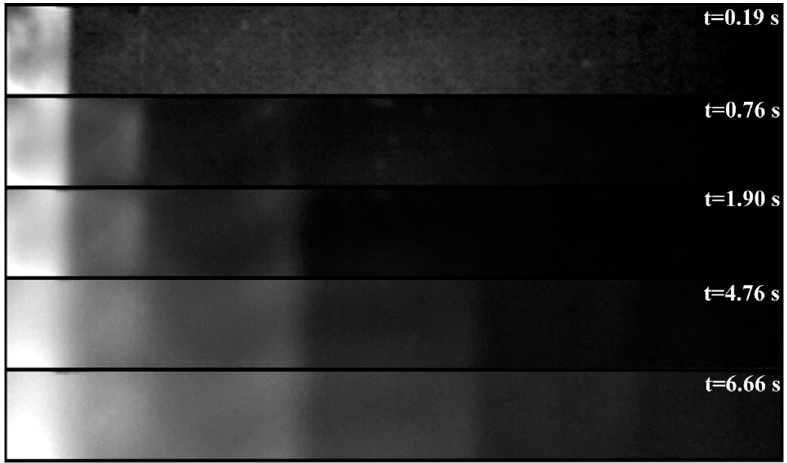
Figure 9. Thermogram sequence for reference gauge.